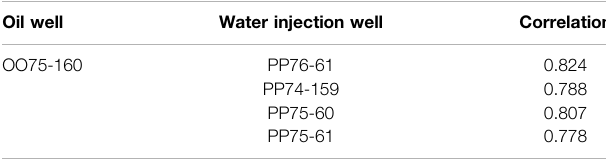
TABLE 1 | The correlations between oil production well OO75-160 and water injection wells. Oil well